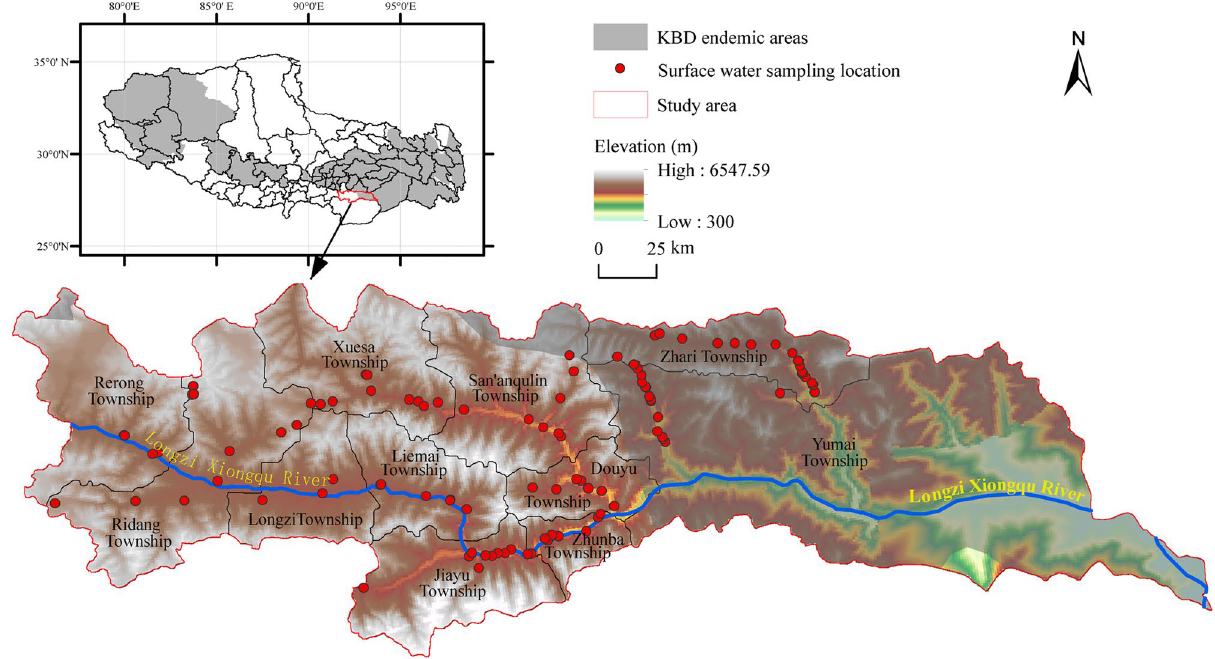
Figure 8. Sampling locations and the KBD endemic areas in the Longzi County (The KBD endemic areas distribution was adapted from Dinh et al. 28 ; this figure was created with ArcGIS 10.8, URL: https:// www. esri. com/ en- us/ arcgis/ produ cts/